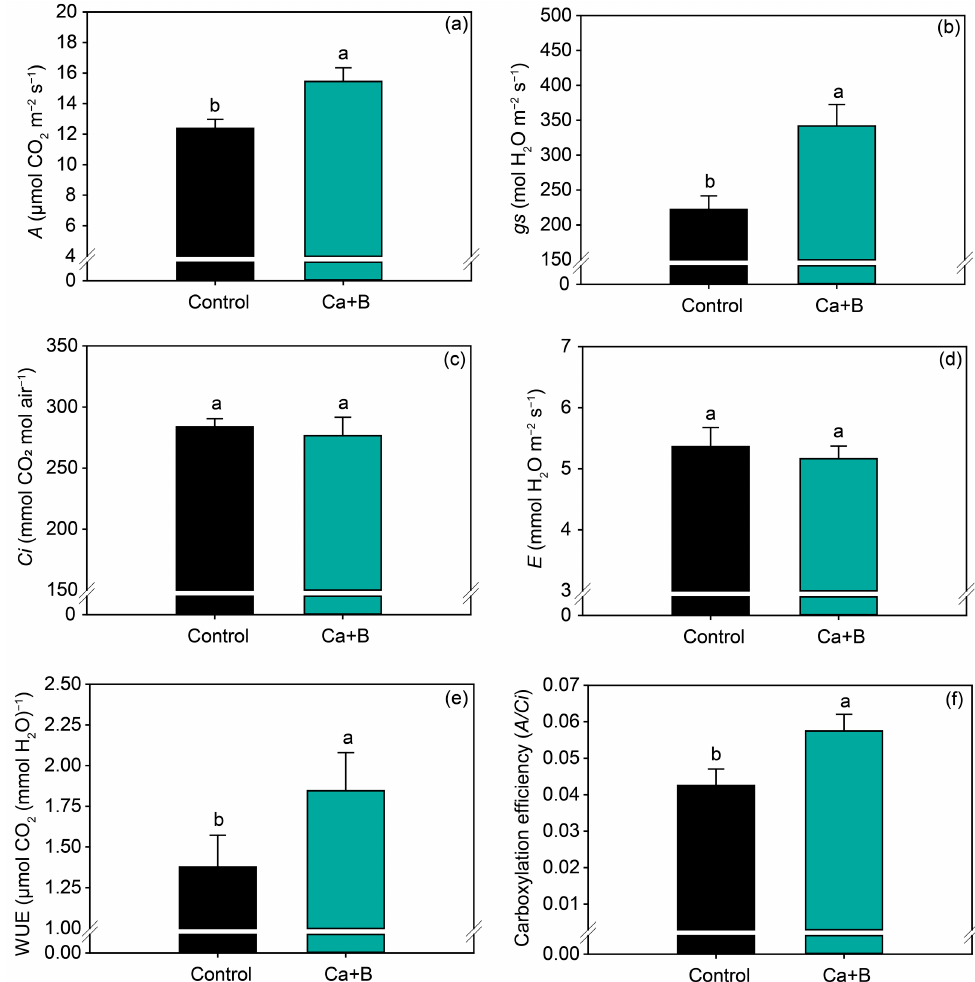
Figure 3. Net photosynthetic rate ( A ) ( a ), stomatal conductance ( gs ) ( b ), substomatal concentration of CO 2 ( Ci ) ( c ), leaf transpiration ( E) ( d ), water use efficiency ( WUE ) ( e ), and carboxylation efficiency ( A / Ci ) ( f ) as a function of foliar application of calcium (Ca) plus boron (B) in the 2019/2020 growing season. Different lowercase letters indicate a significant difference between Ca + B treatments by Fisher’s test ( p ≤ 0.05). Error bars express the standard error of the mean ( n = 12).